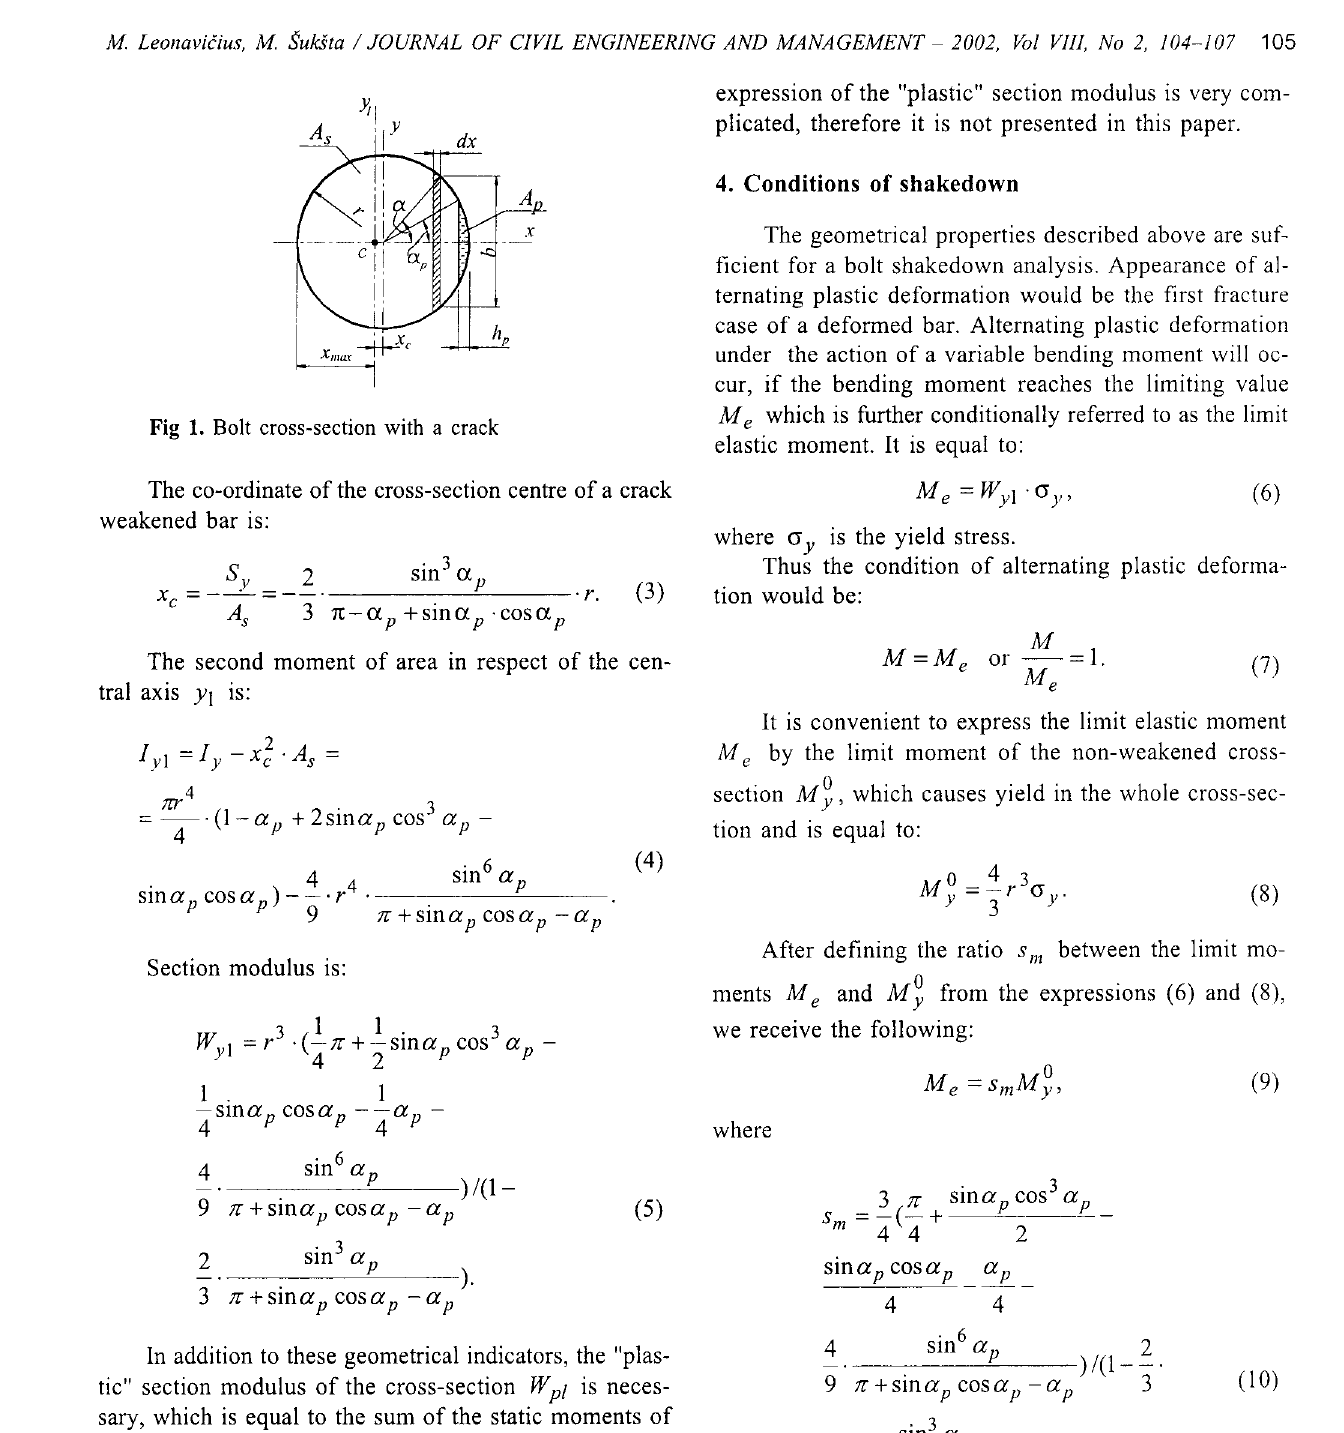
Fig 1. Bolt cross-section with a crack The co-ordinate of the cross-section centre of a